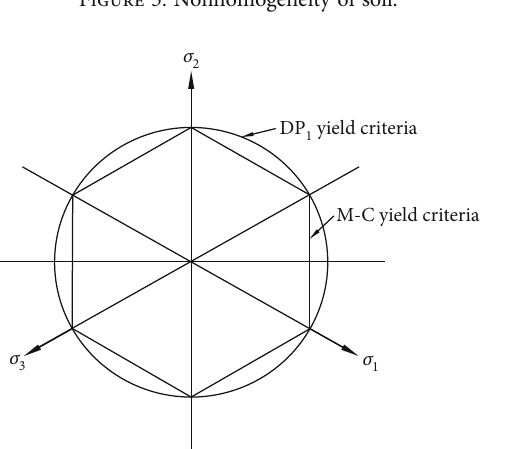
Figure 5: Nonhomogeneity of soil.